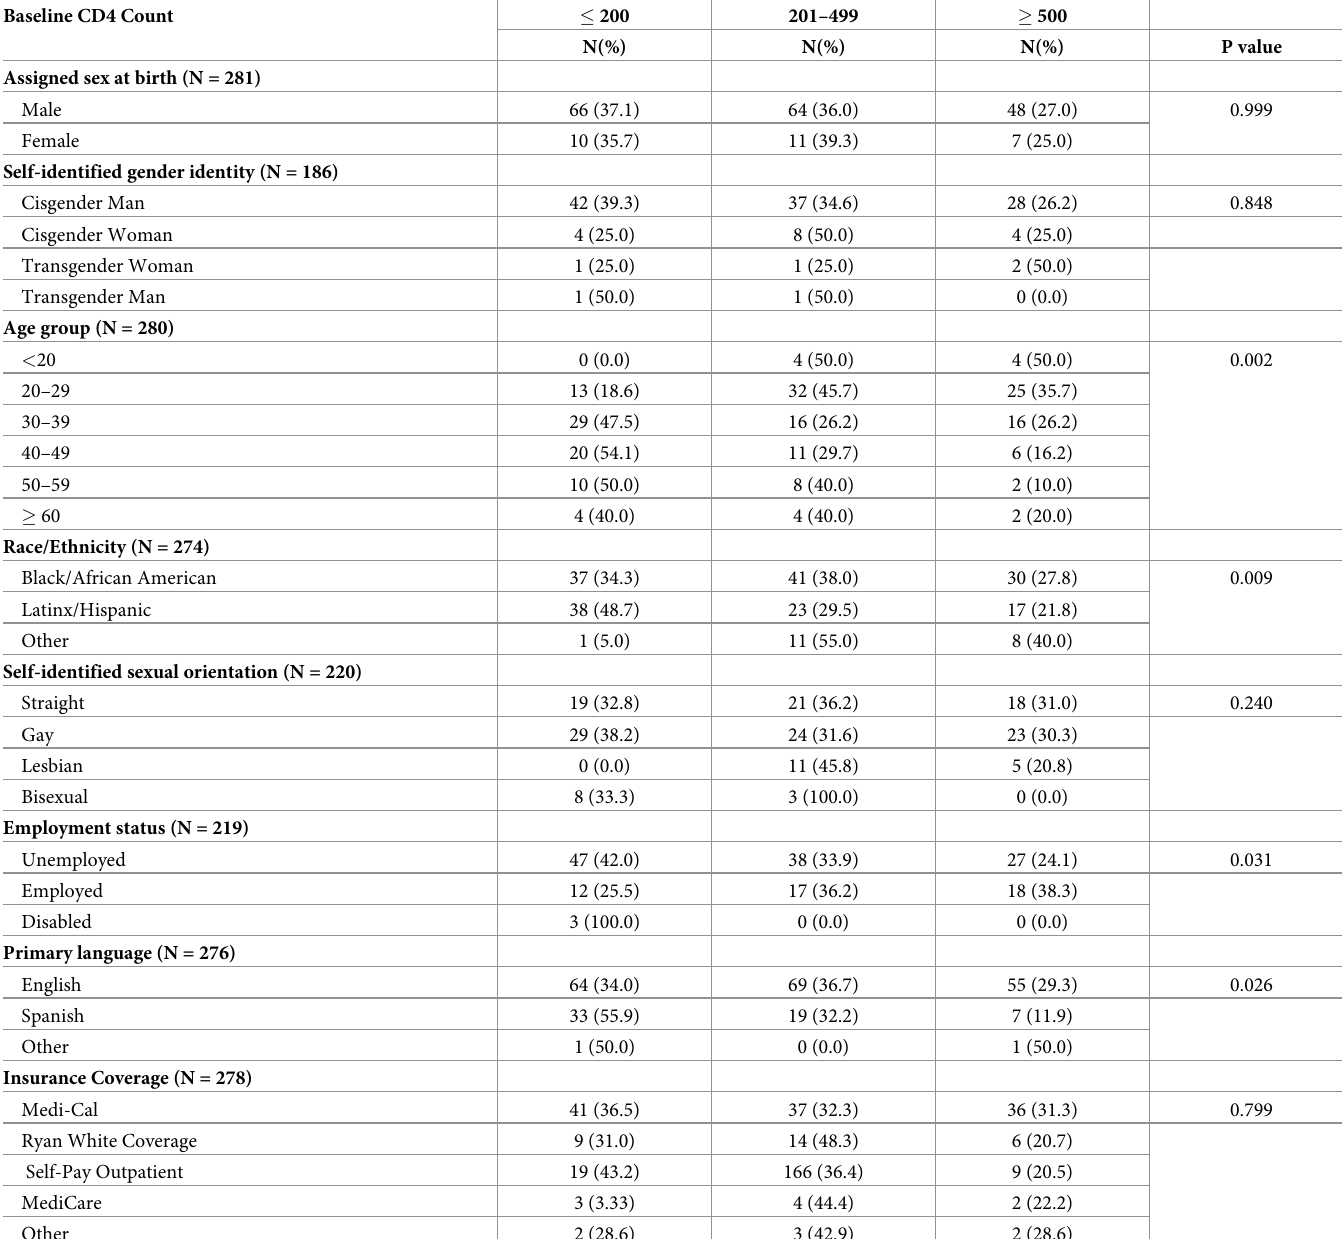
Table 2. Baseline CD4 of newly diagnosed HIV-positive clients in 2016–2020 by demographic characteristics, excluding white (N =